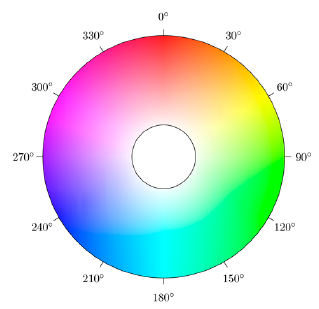
Figure 3. The color space of hue vector.